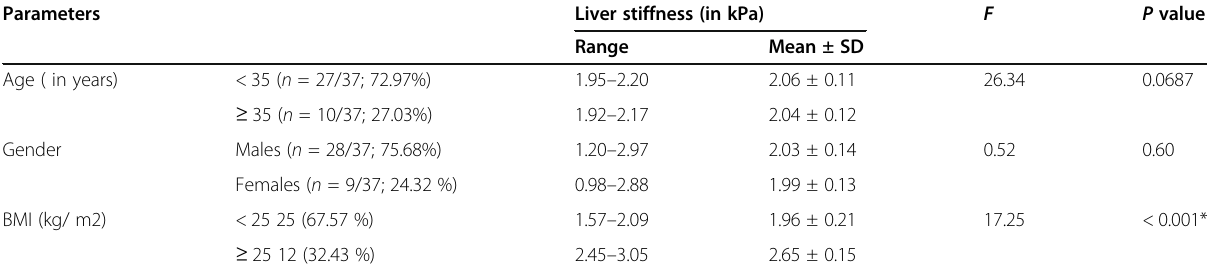
Table 3 The mean liver stiffness values (estimated by MRE) in relation to age, sex, and BMI of the study participants ( n = 37) Parameters Liver stiffness (in